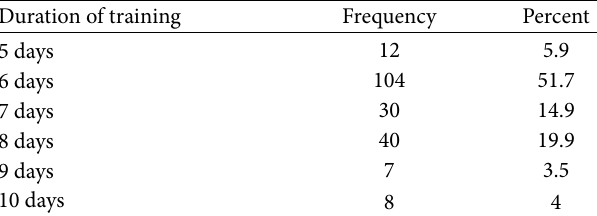
Table 3: Duration of IMNCI training.